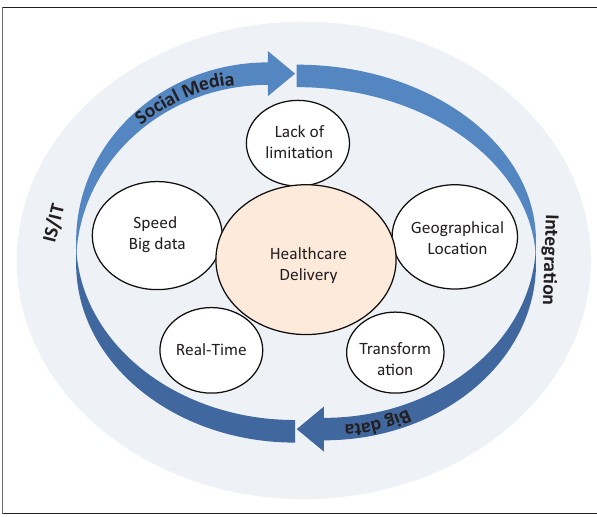
FIGURE 1: Factors of influence for social media and healthcare big